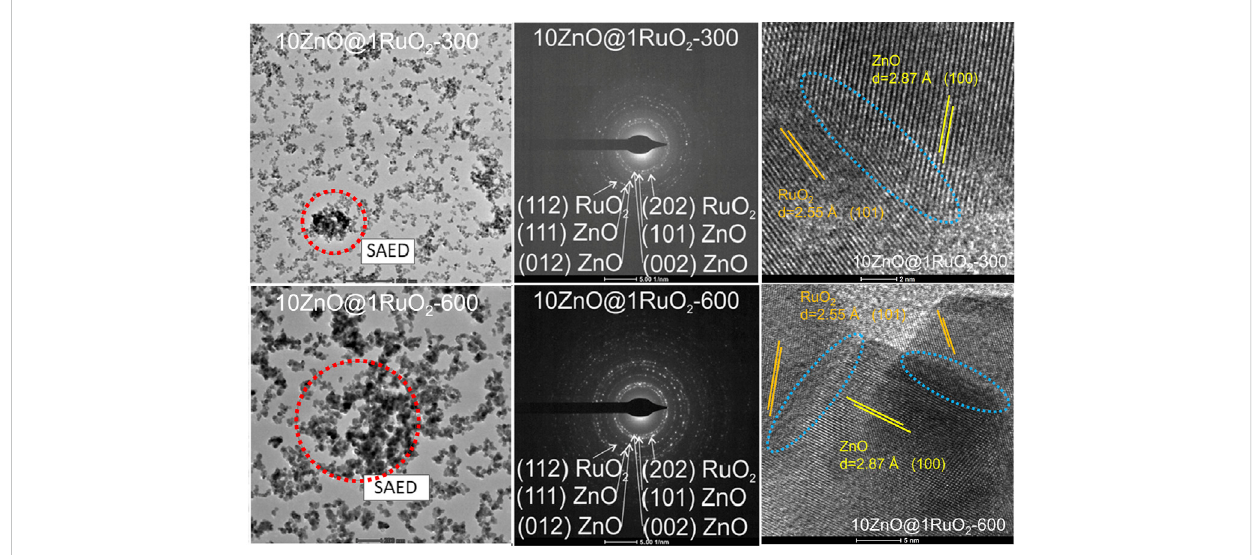
FIGURE 7 TEM, corresponding SAED pattern, and HRTEM with marked heterojunctions of 10ZnO@1RuO 2 -300 and 10ZnO@1RuO 2 -600 powders.